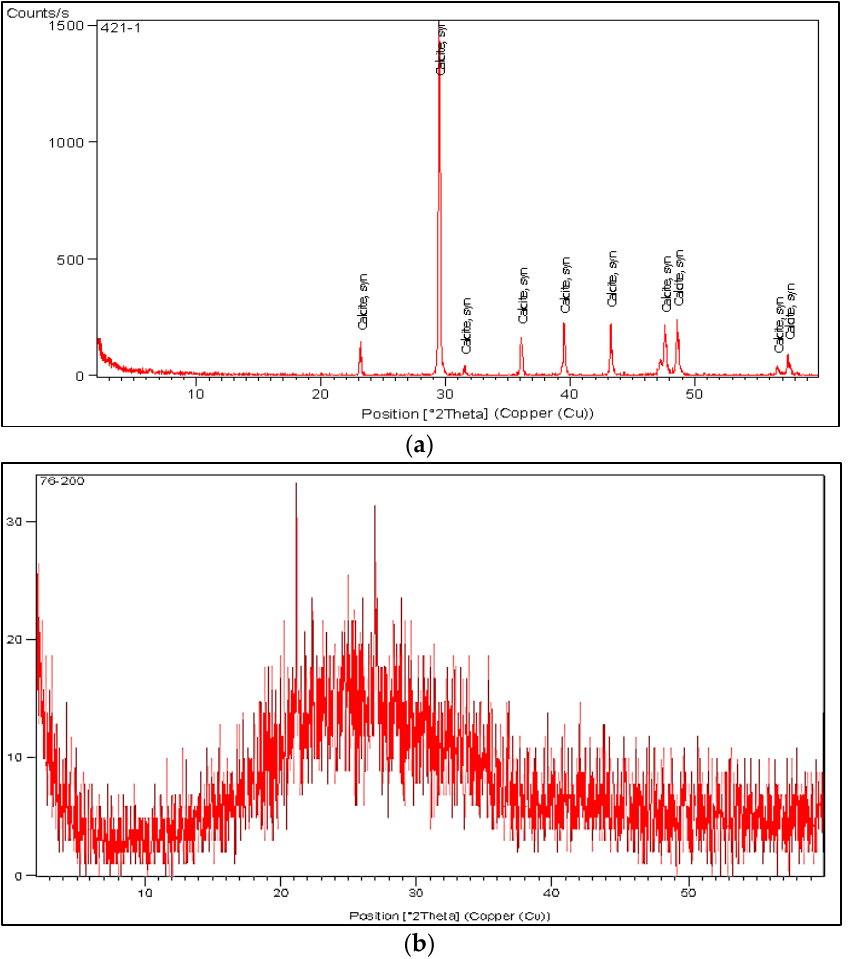
Figure 2. Lime and glass powder X-ray diffraction patterns. ( a ) Lime powder. ( b ) Glass powder.